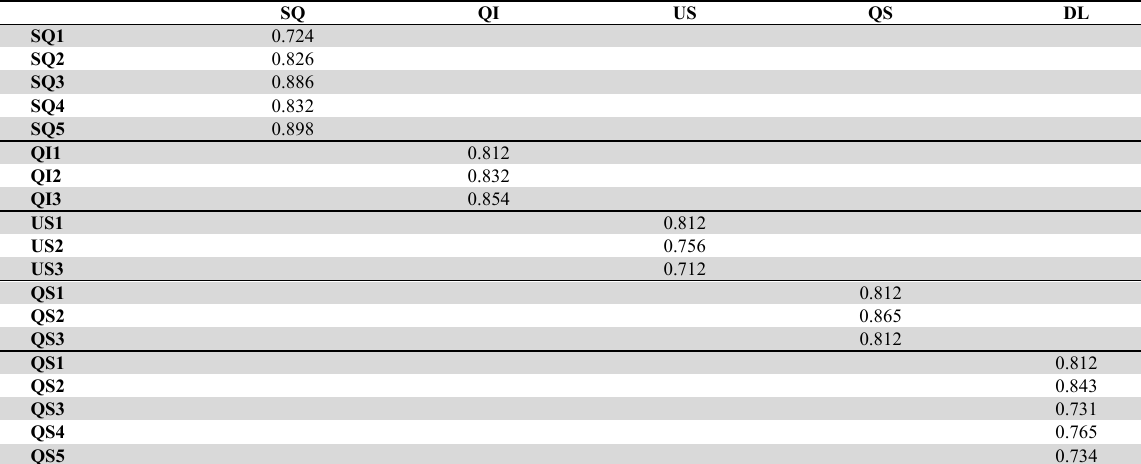
The results of outer loading